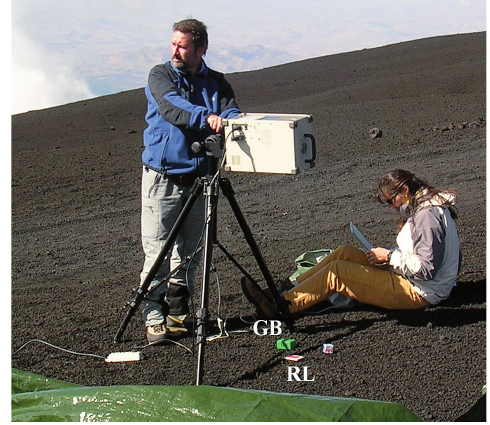
Fig. 1. The Konica Minolta VI-910 3D digitizer mounted on the tripod elevated about 1 m above the ground surface covered by coarse grained tephra, just north of the 2002-2003 vents (Sample S8 in fig. 2). Green box (GB) and red labels (RL) below the Laser 3D are used as reference features. The green canvas in the foreground is used to reduce the envi- ronment